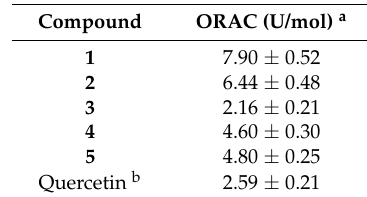
Table 2. Antioxidant activities of compounds 1 – 5 .